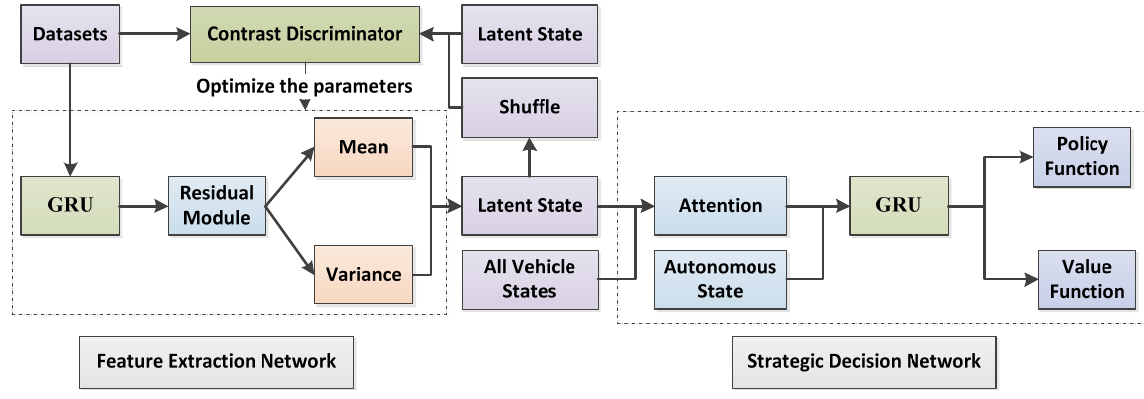
Figure 3. The whole framework of the C-ResNet-VAE + RNN network.